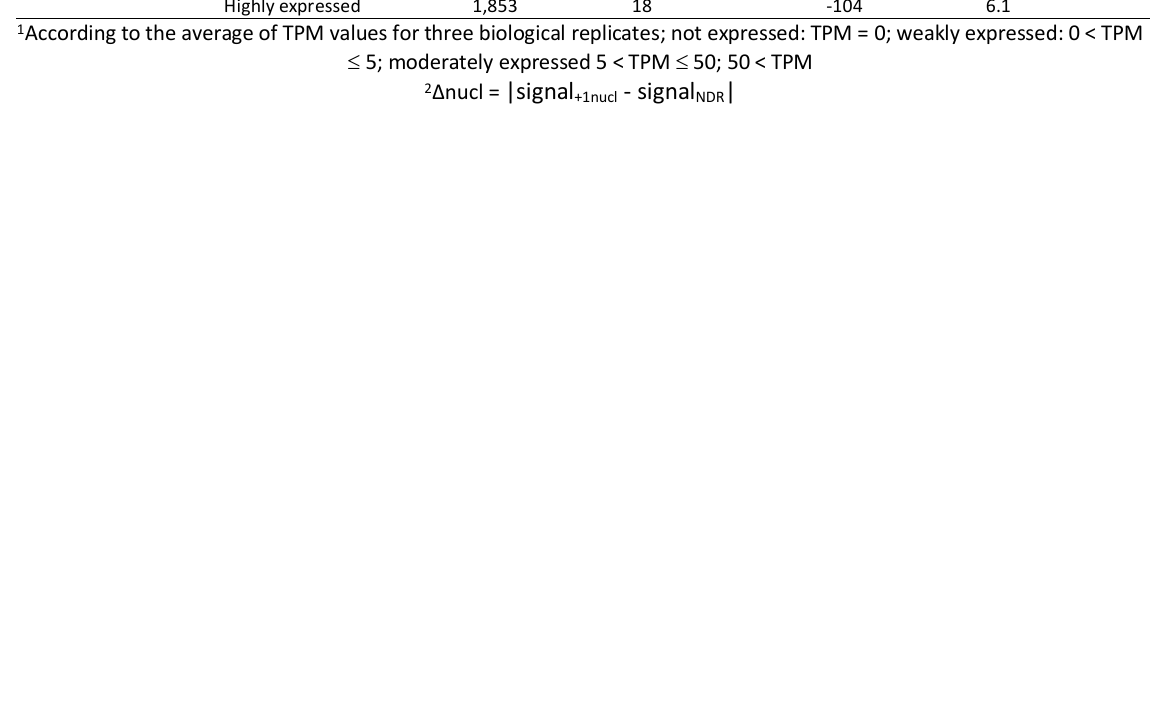
Leptosphaeria maculans